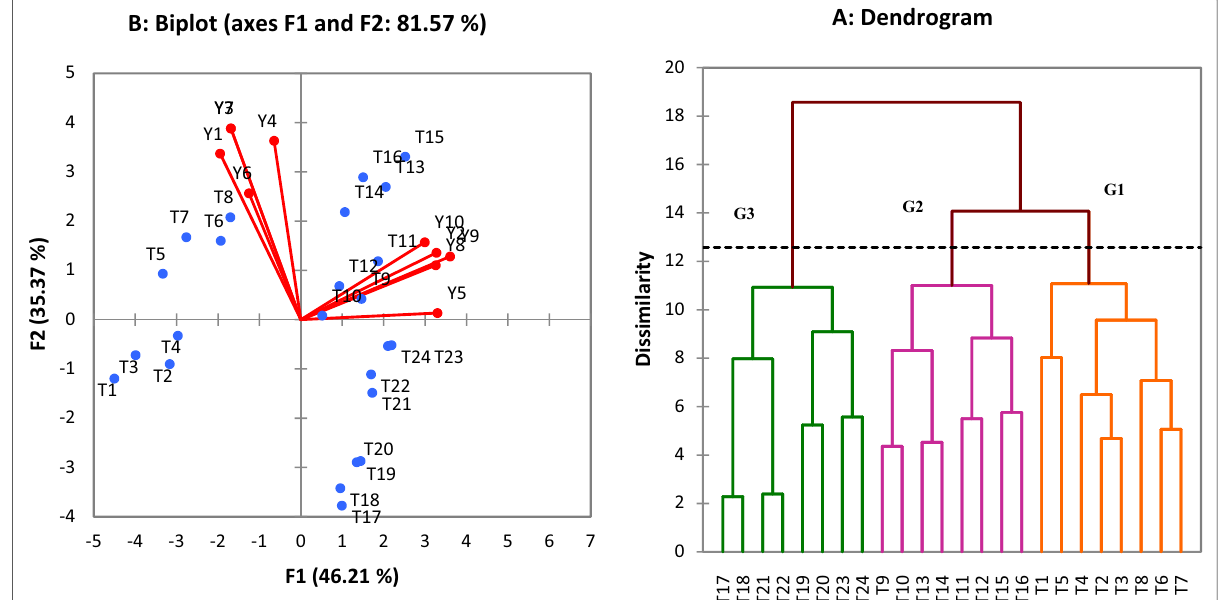
Fig. 2 The results of dendrogram based on cluster analysis ( A ) and biplot of first and second components based on principal component analysis ( B ). Y